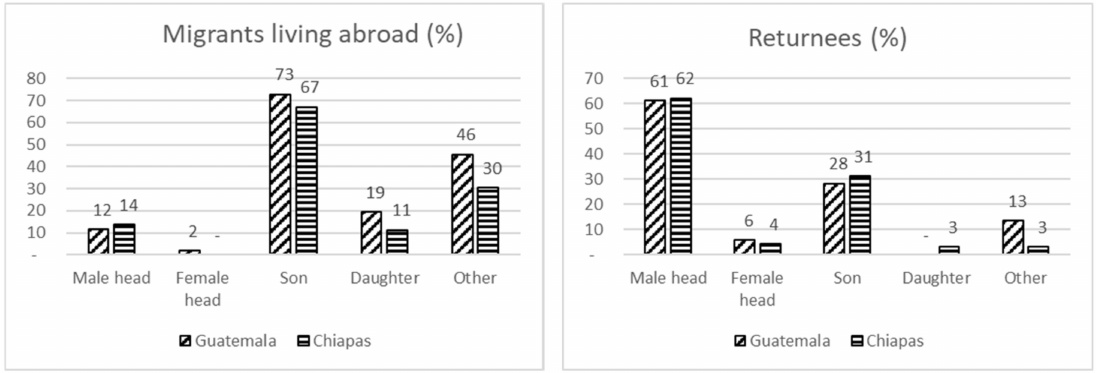
Figure 3. Migration by household